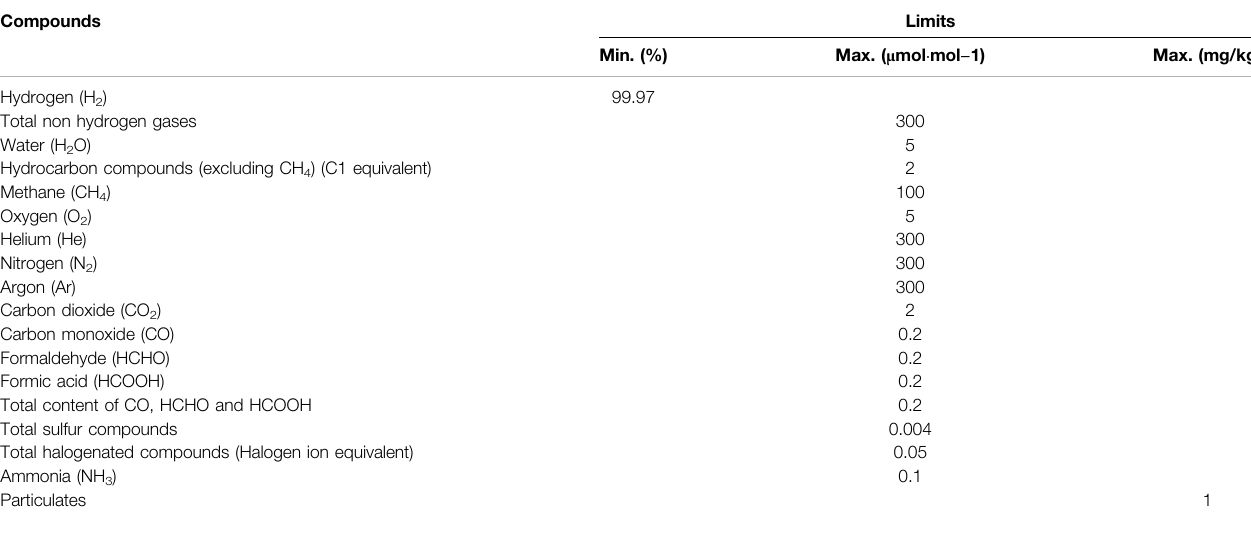
TABLE 1 | Hydrogen quality requirements speci fi ed in ISO 14687:2019, EN 17124 and SAE J2719 standards (ISO/TC 197 2019) (CEN/TC 268 2018) (SAE Fuel Cell Standards Committee, 2020).